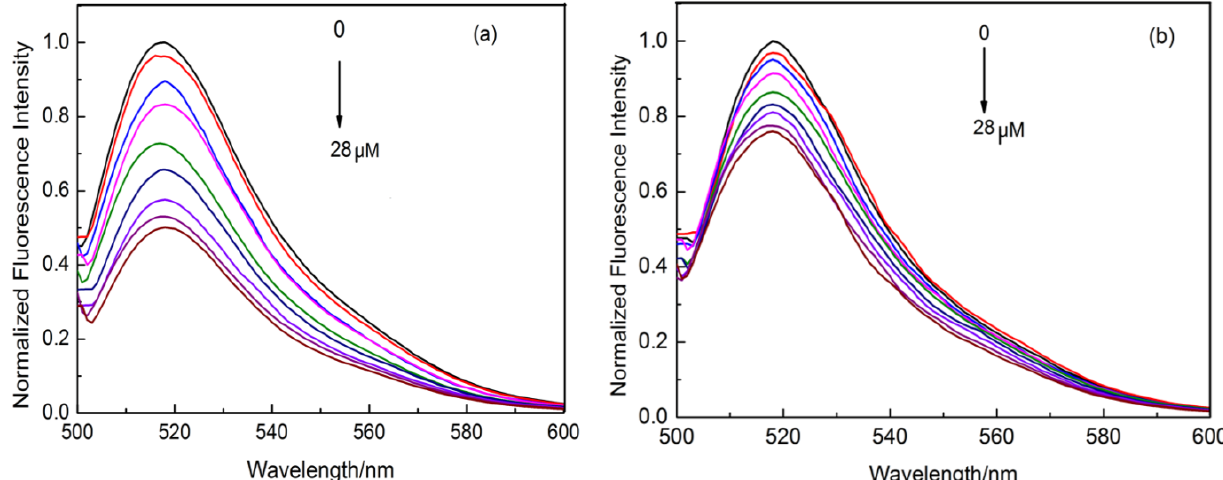
Figure 3. Fluorescence spectra ( λ ex = 493.0 nm) of the MIP ( a ) and NIP ( b ) with increasing Lys concentration in the PBS